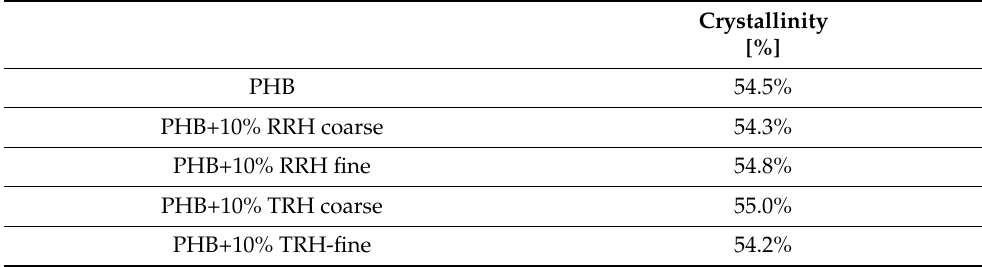
Table 2. Percent crystallinity for the extruded